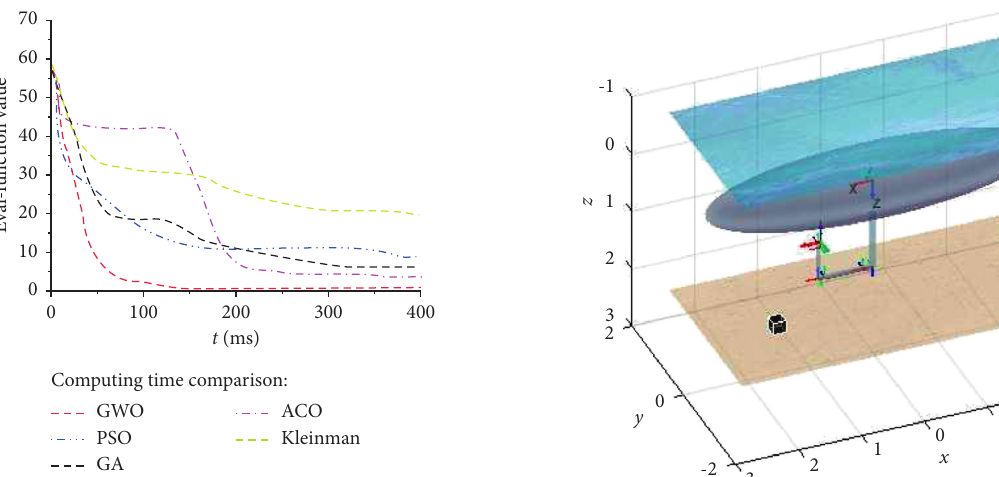
Figure 7: The history of tracking errors of the desired trajectory and end effector with and without the NDO or H history of X error values of the desired trajectory and end effector. (b) Time history of Y error values of the desired trajectory and end effector. (c) Time history of Z error values of the desired trajectory and end effector.